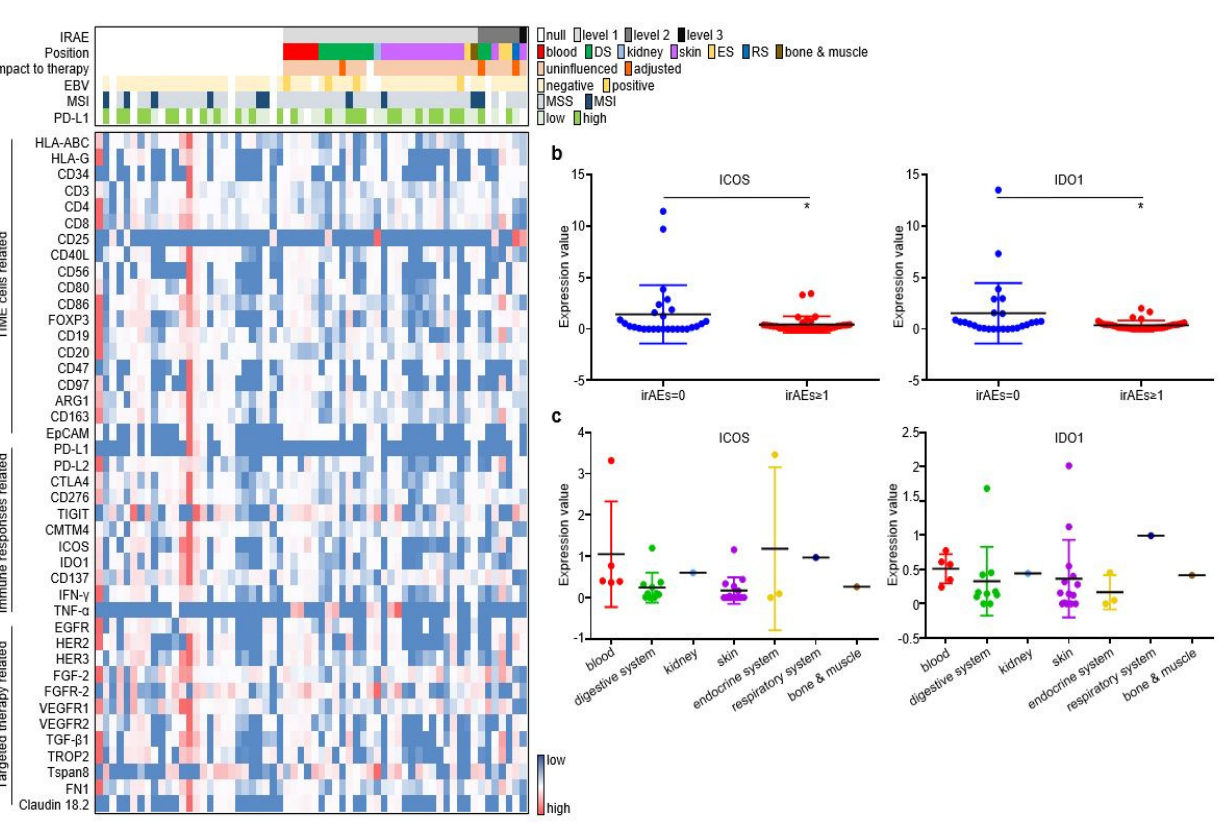
Figure 2. ICOS and IDO1 were screened to predict the occurrence of irAEs in 62 ICI-treated GC patients. ( a ) EV-proteins heat map in the discovery cohort. ( b ) EV-ICOS and EV-IDO1 were screened to monitor irAEs. ( c ) The expression degree of EV-ICOS and EV-IDO1 in different organs of GC patients with irAEs. (* p < 0.05, 1, ns: non-significant).